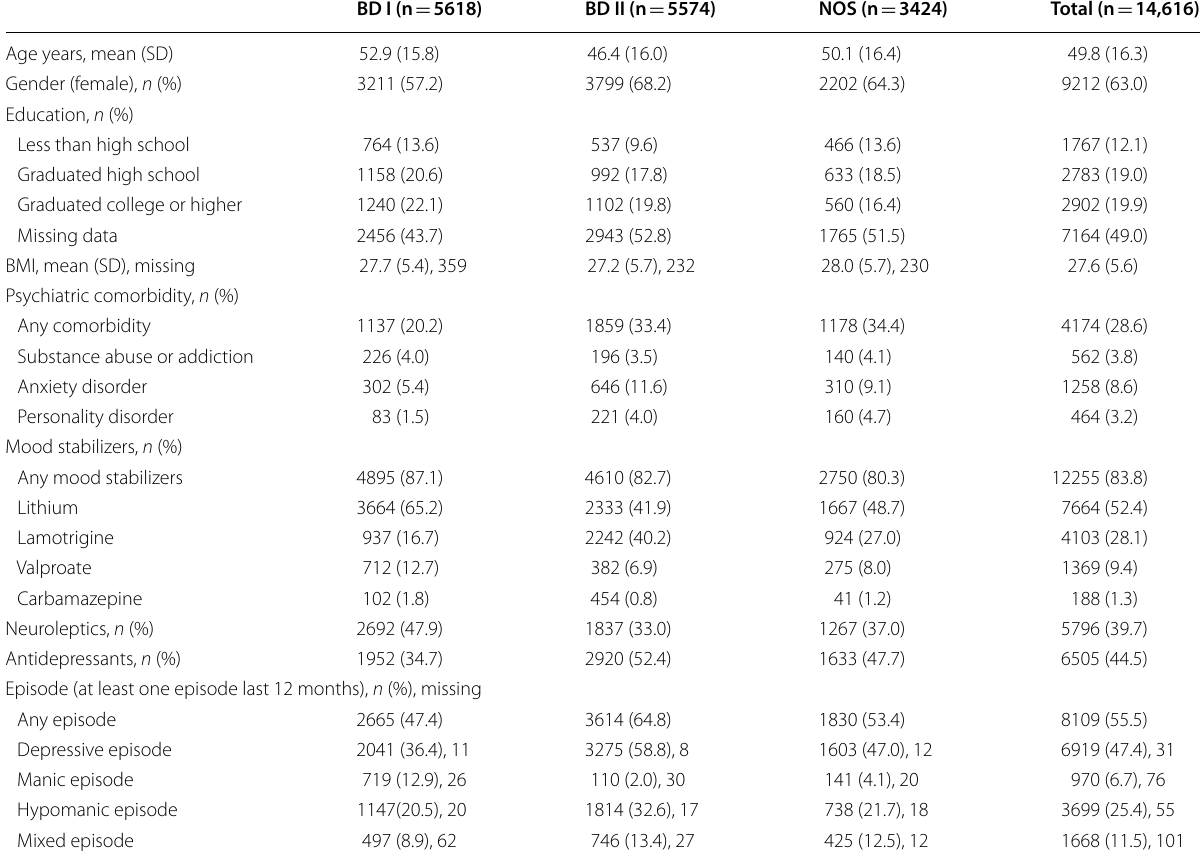
Table 1 Descriptive data for the study populations with BD I, BD II, BD NOS and the combined